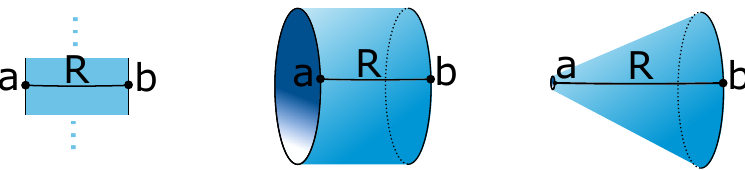
Figure 7 . Left: Hilbert space of BF on I . Middle: Thermal Cylinder. Right: thermal disk obtained by shrinking the left boundary by redshift.